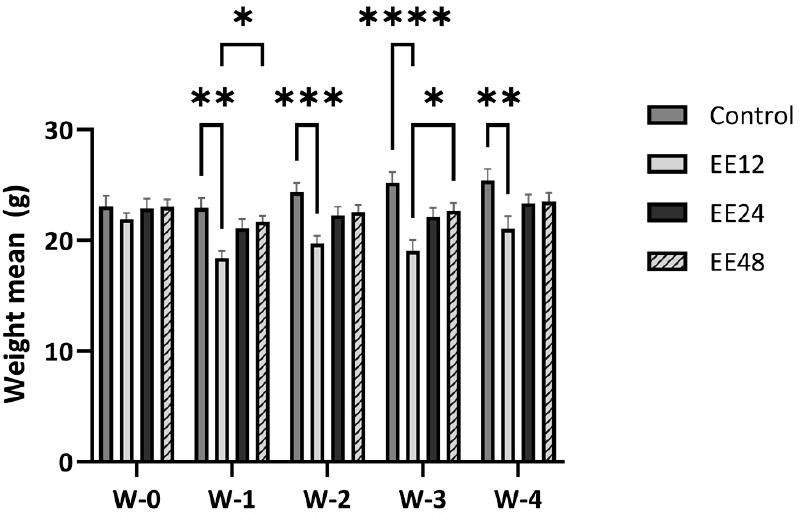
Figure 2. Body weight (g) mean [ ± Standard error (SE)] throughout the experiment. Statistically significant differences are denoted by asterisks: * p < 0.05; ** p < 0.01; *** p < 0.001; **** p < 0.0001. Regarding food and drink intake, all of the groups had relatively similar average daily food and drink intake values (Table 1). Table 1. Mean daily values of food and drink intake (g) per experimental group during the four weeks. Food Groups